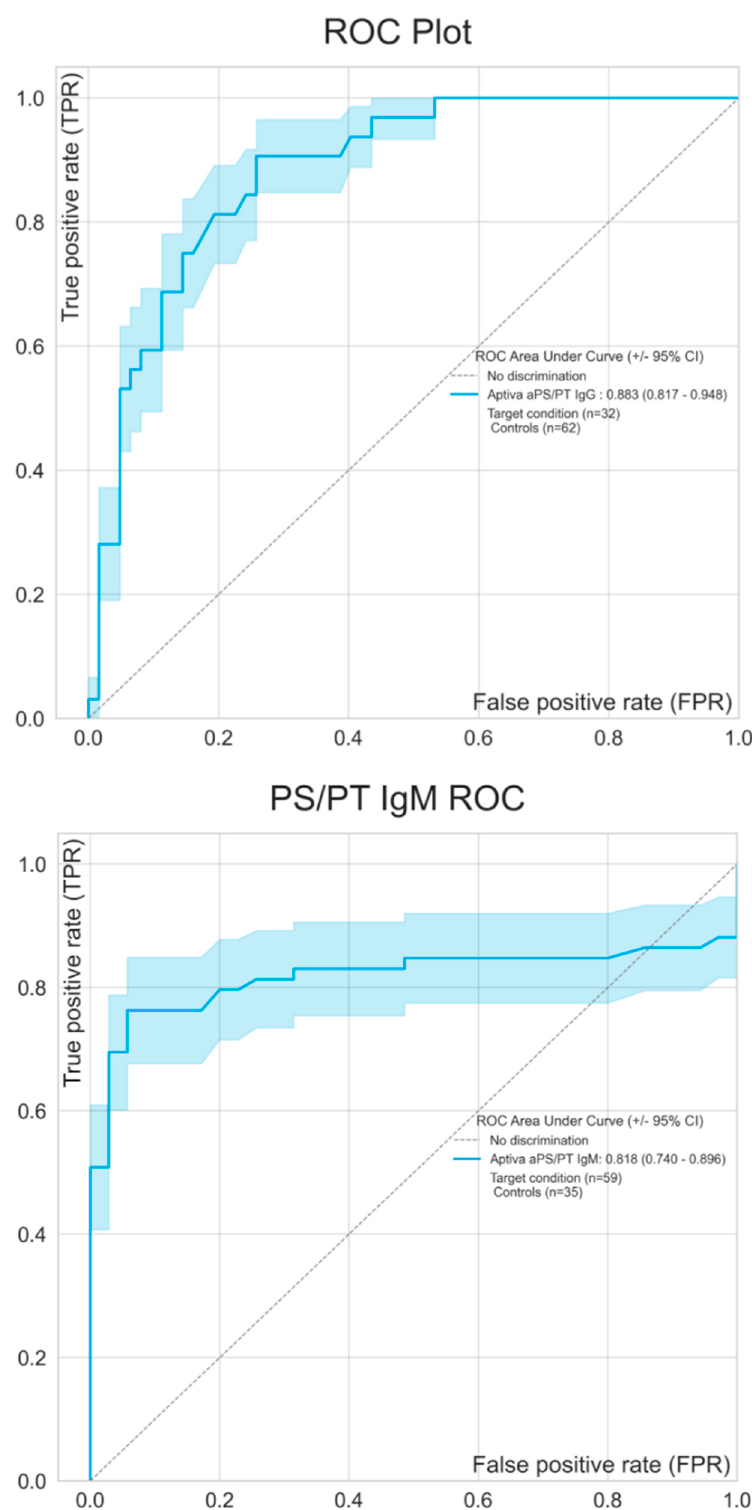
Figure 4. Receiver operating characteristic (ROC) analysis comparing ELISA as the reference method with PMAT. Results obtained from ELISA were used as binary classifier and employed to generate ROC curves using the numerical results obtained by PMAT. 95% confidence intervals are shown using the shaded areas. aPS/PT means antiphosphatidylserine/prothrombin antibodies; ELISA, enzyme-linked immunosorbent assay. Table 1. Main demographic, clinical and laboratory characteristics of the patients included in the study.